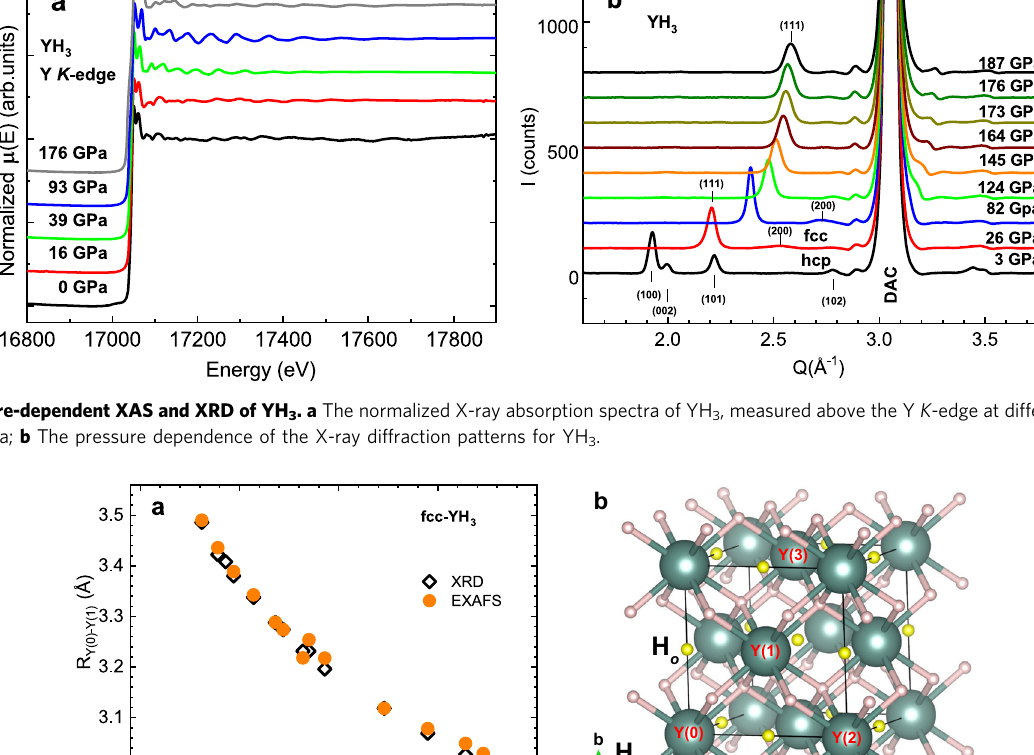
Fig. 2 The crystal structure of YH 3 . a Pressure dependence of the interatomic distance R ð Y ð 0 Þ (cid:2) Y ð 1 ÞÞ ¼ a = obtained from XRD versus Y K -edge EXAFS data; b Crystal structure of fcc YH 3 phase. Y(0) and Y(2) denote yttrium atoms in the corners of the cube, while Y(1) atoms are in the centers of nearest faces and Y(3) atoms are in the centers of the neighbor faces. Small white balls mark hydrogen atoms H t in tetrahedral positions and yellow ones - H o in octahedral